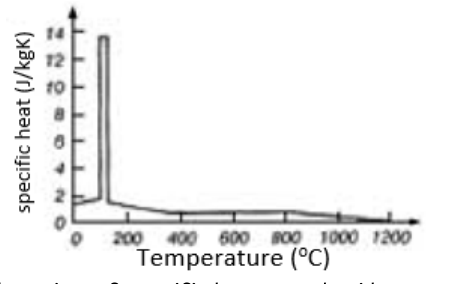
Figure 9. Changing of specific heat wood with temperature